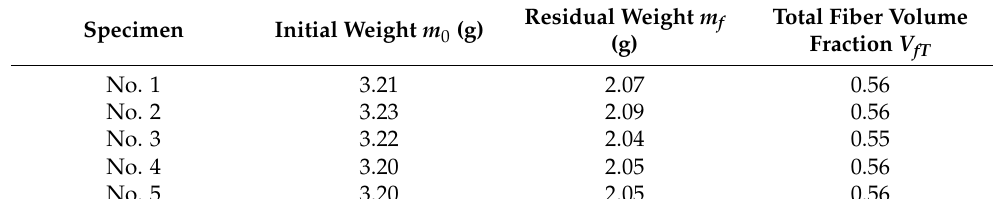
Table 5. Mechanical properties of the fiber tows in the T300/Cycom970 plain-woven fabric compo- Table 3. Results of the thermal ablation experiments. site.